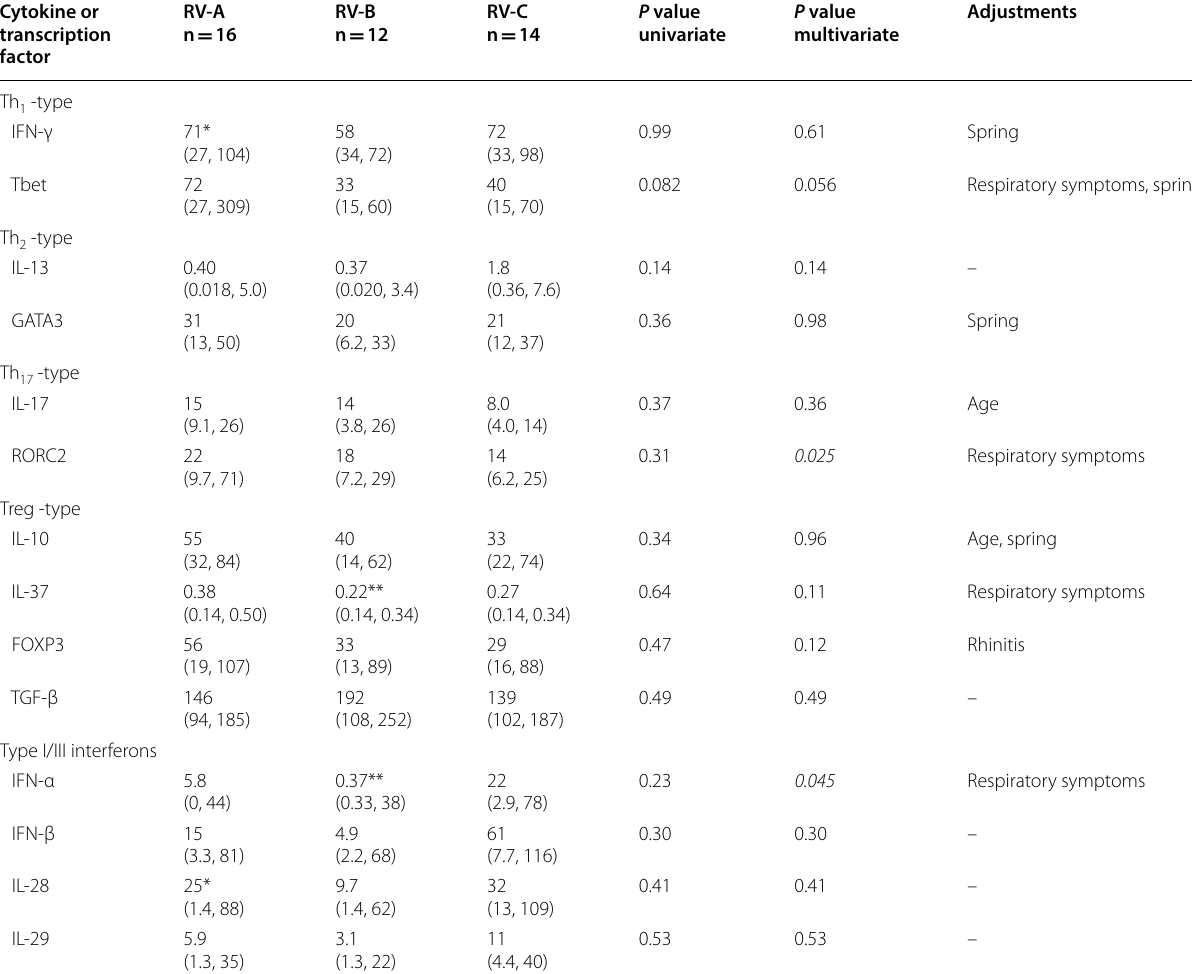
Table 3 Cytokine or transcription factor